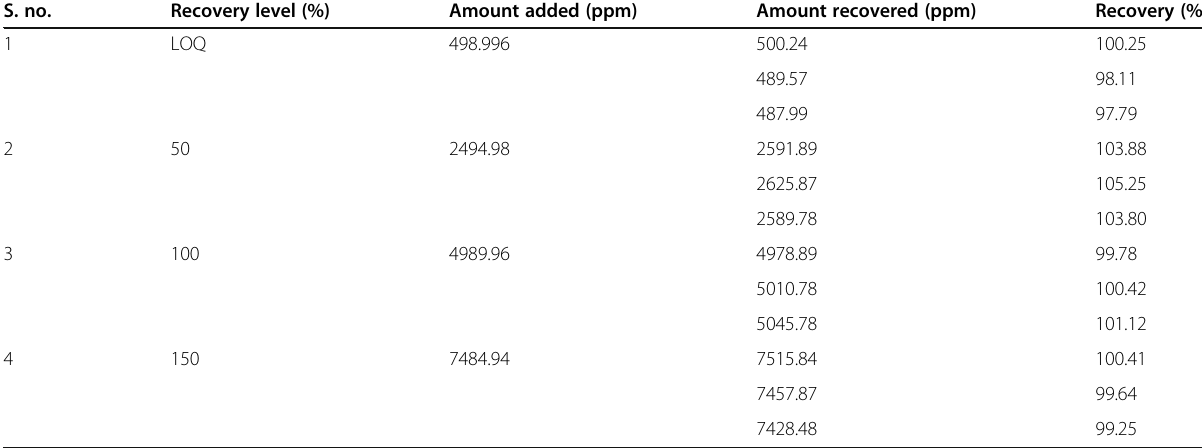
Table 10 Results of recovery study for acetone S.